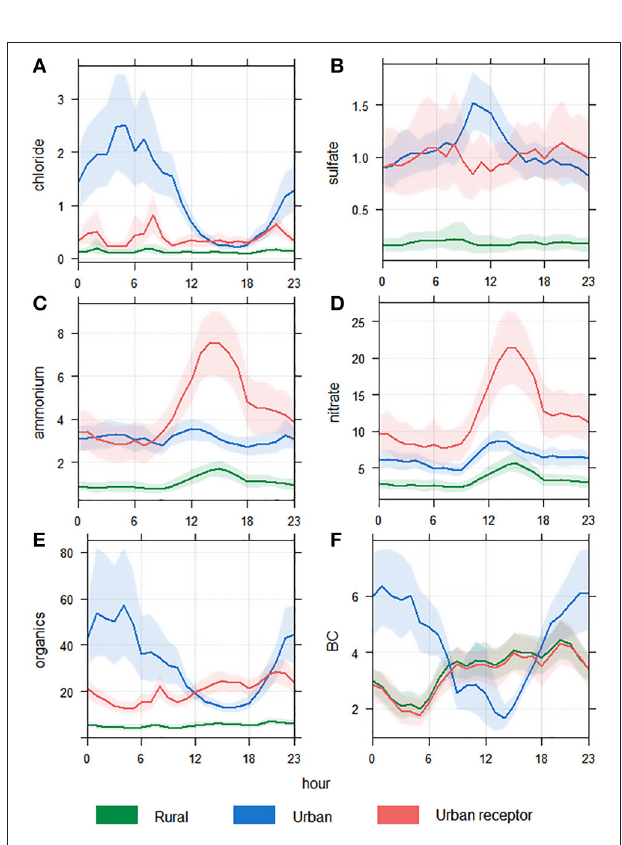
FIGURE 7 | Hourly temporal profile of 1-h average concentrations ( µ g m − 3 ) during the winter season. (A) chloride, (B) sulfate, (C) ammonium, (D) nitrate, (E) organics, (F) black carbon. Mean (solid line) and 95% confidence intervals in the mean (darkened area).